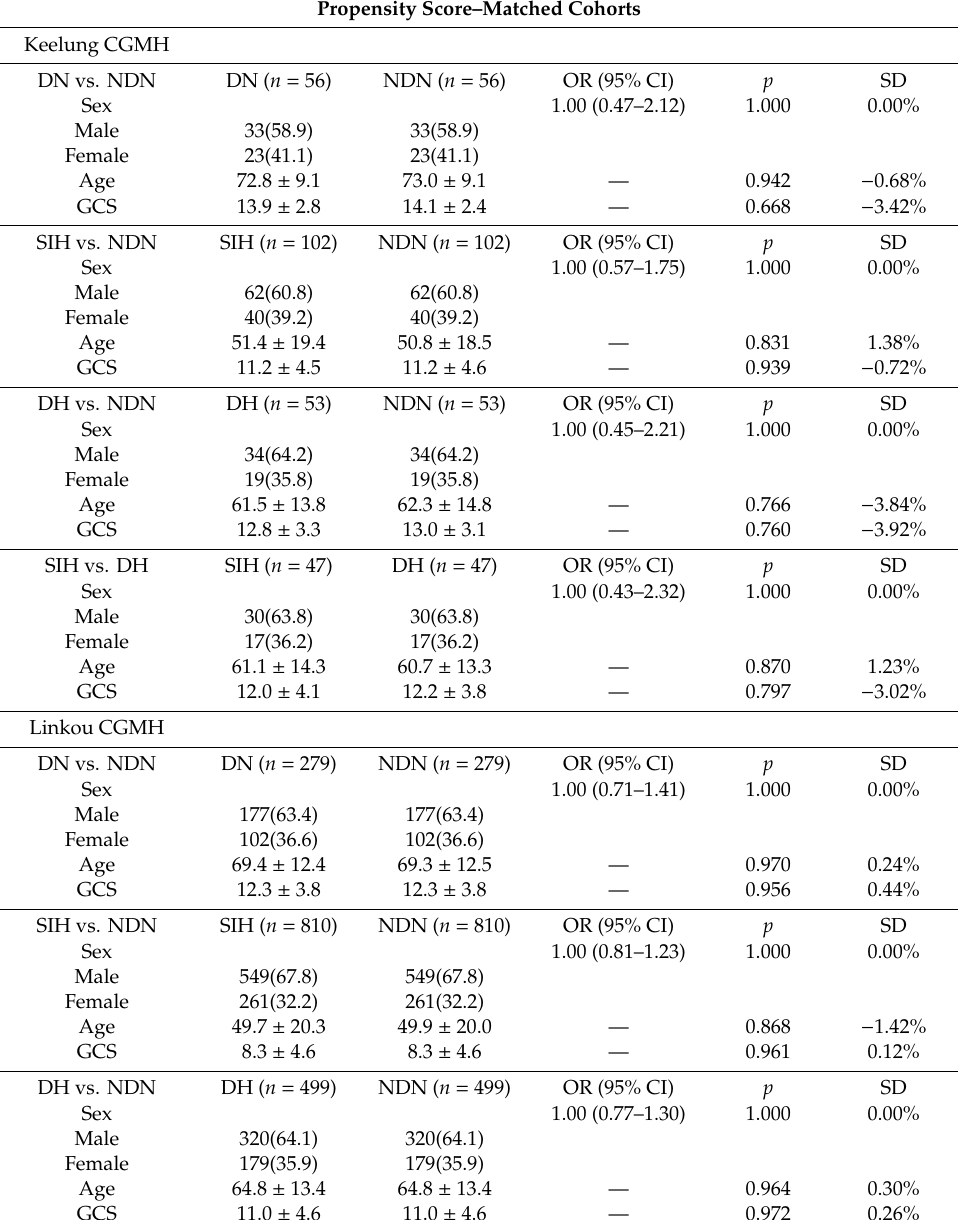
Table 3. Well-balanced propensity score-matched cohorts among the four groups (NDN, DN, SIH, DH) of patients with traumatic brain injuries within each hospital were